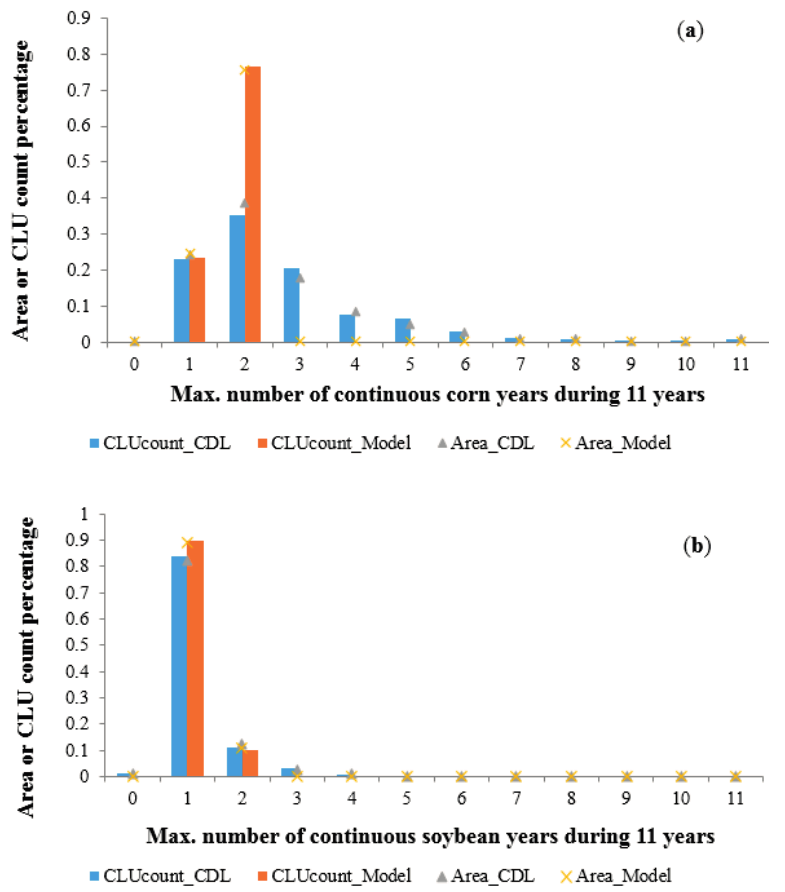
Figure 2. Maximum number of continuous corn ( a ); and soybean ( b ) years during an 11-year time